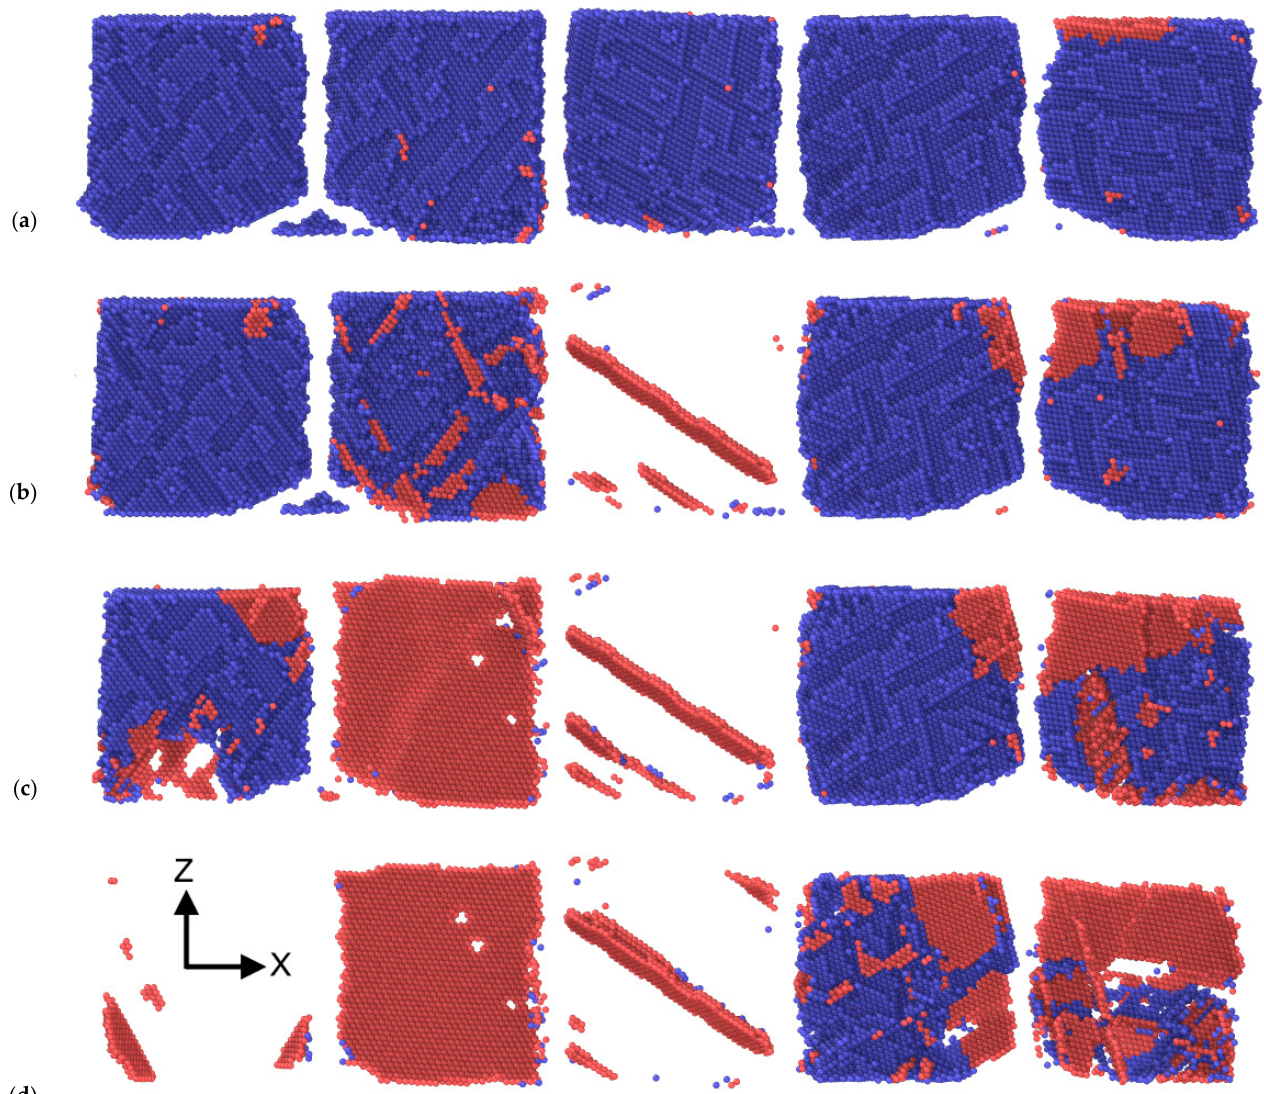
Figure 6. Cross-sections of a small-grained layer by the XZ plane at the strains: 1.75 ( a ), 3.00 ( b ), 4.25 ( c ), and 6.75% ( d ). Atoms with bcc and hcp nearest neighbor symmetry are highlighted in blue and red, respectively. The rest atoms are not shown.